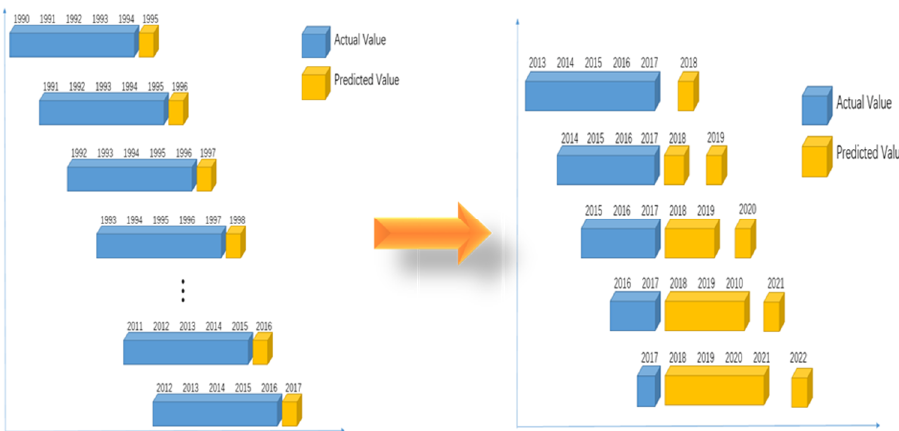
Figure 5. The cyclic mode of the MGM (1,1)